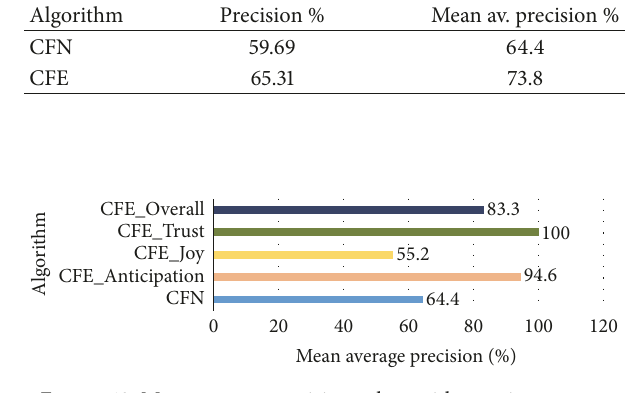
Figure 10: Mean average precision values with emotion